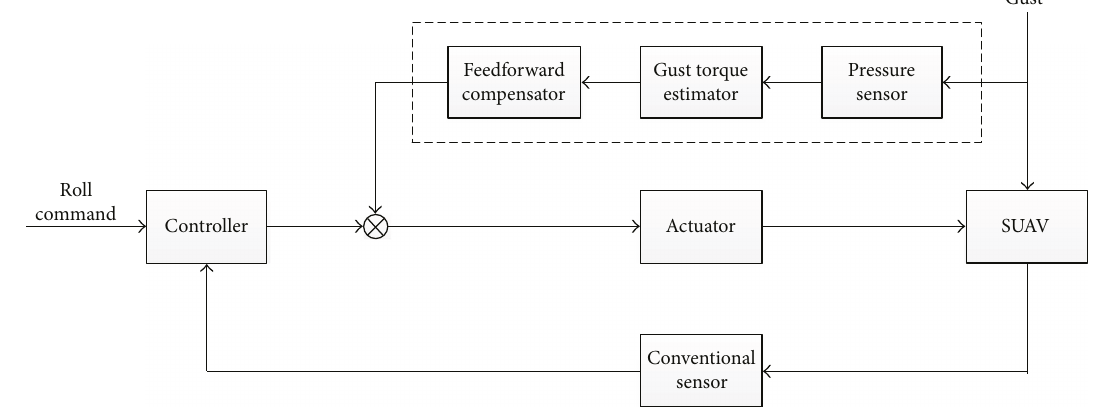
Figure 3: The pressure sensor-based gust perturbation alleviation control architecture.